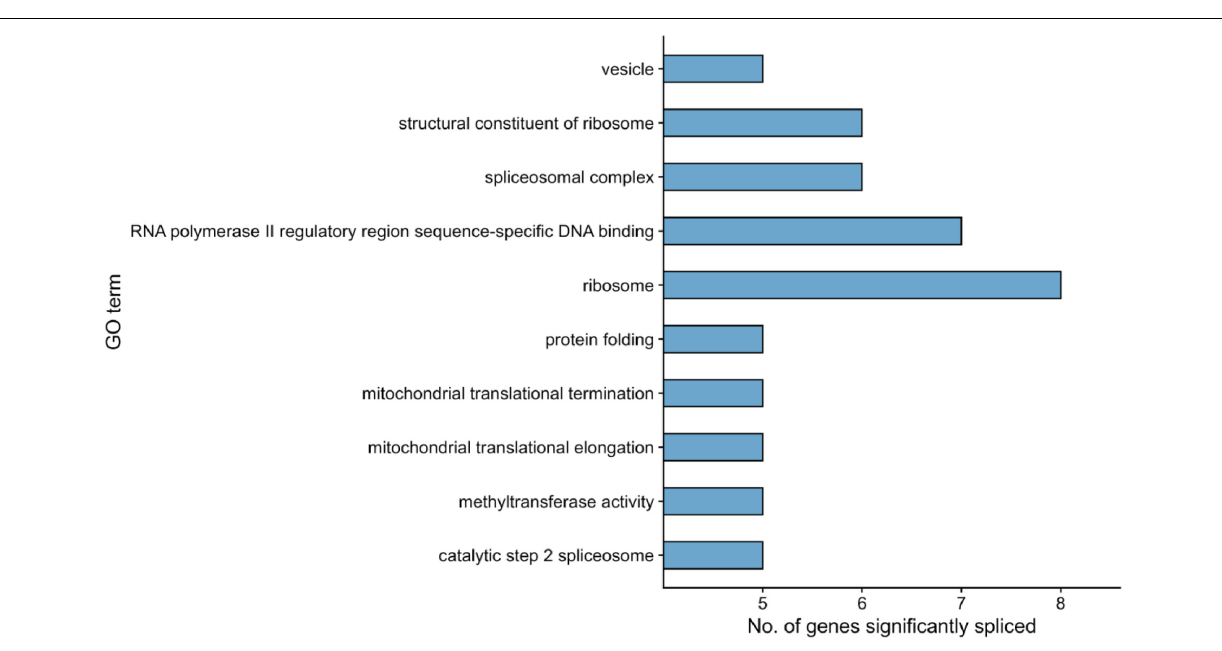
FIGURE 4 | Functional enrichment results for differentially spliced genes in the RPE contrast (Control-RPE vs. Patient-RPE, only unique events). The top-10 most frequently annotated GO terms are shown in the y -axis. The number of genes belonging to each GO term is indicated by bar height ( x